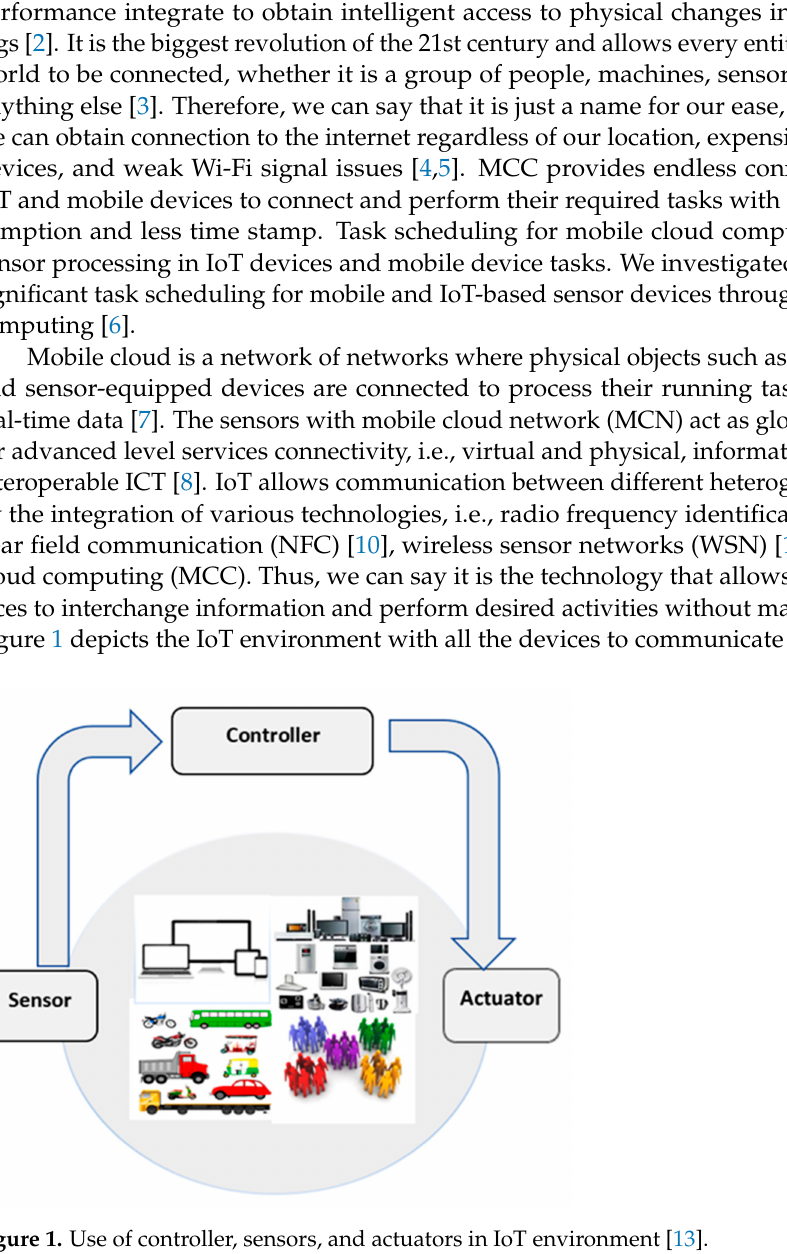
Figure 1. Use of controller, sensors, and actuators in IoT environment